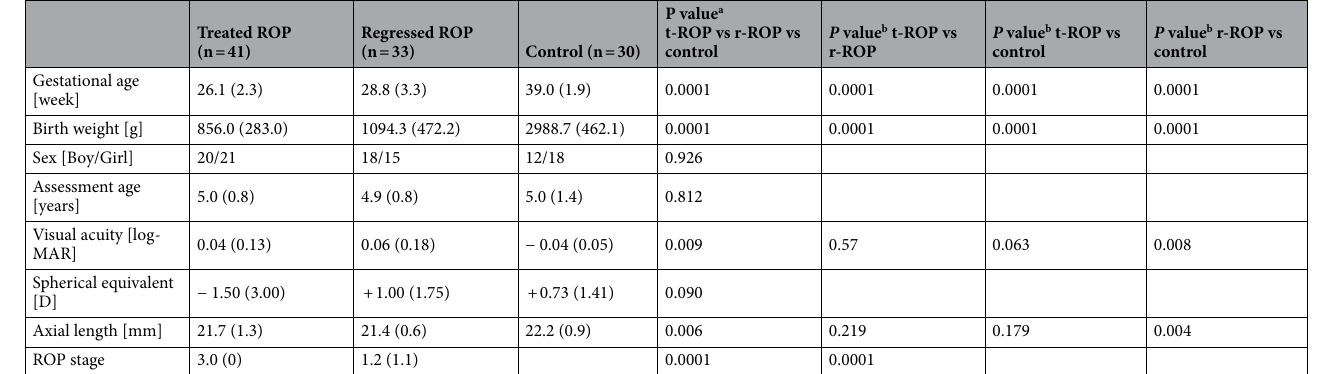
Table 1. Demographics of the patients and controls. Data are expressed as mean (standard deviation). P value: a analysis of variance (ANOVA) b Tukey. logMAR: logarithm of the minimum angle of resolution, ROP: retinopathy of prematurity, t-ROP: treated ROP, r-ROP: regressed ROP.